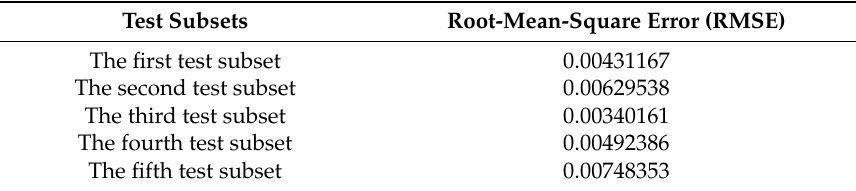
Table 1. Five root-mean-square error (RMSE) of KELM model.